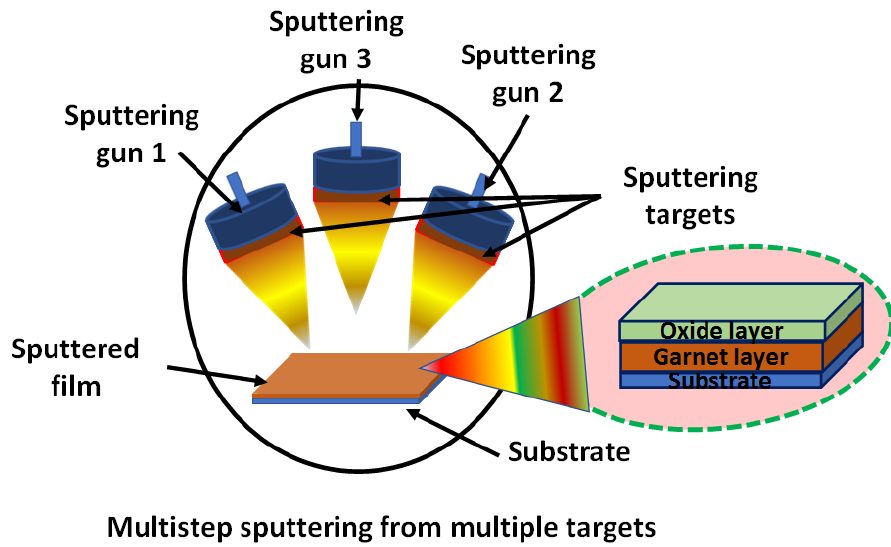
Figure 3. Schematic diagram of a multistep sputtering technique used for garnet/oxide multilayer (garnet layer under protective layer) structures deposition.